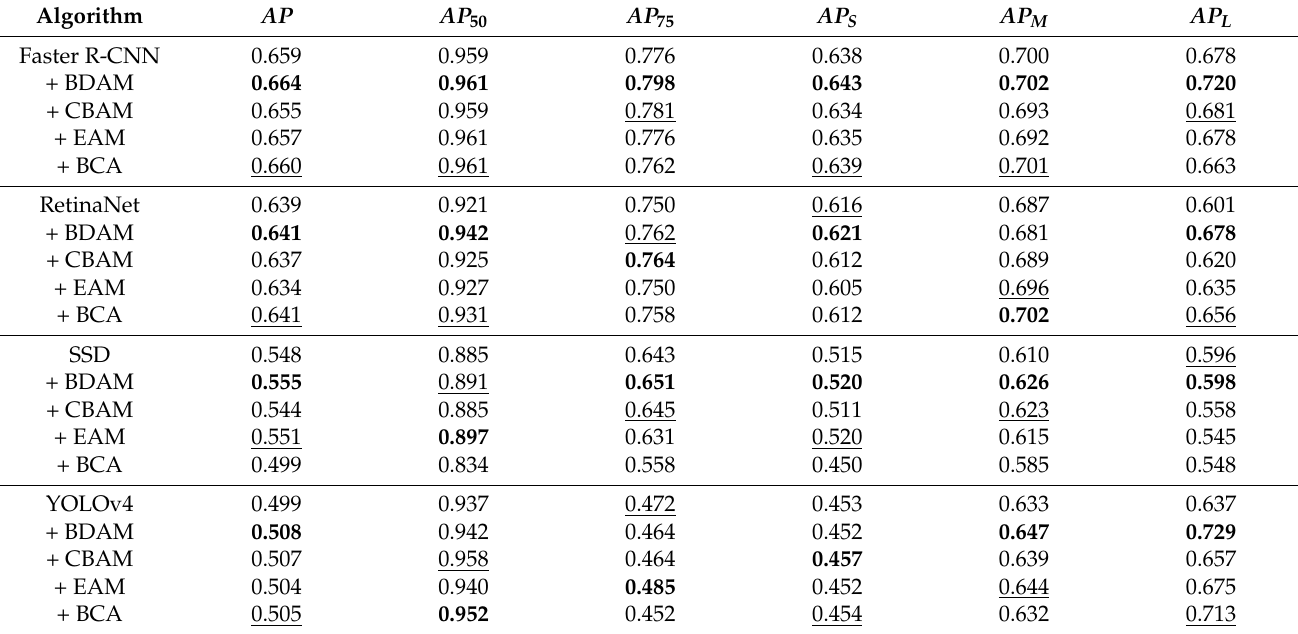
Table 6. Experimental results of different algorithms on dataset SSDD. Bolded data represent the best and underlined data represent the second best.